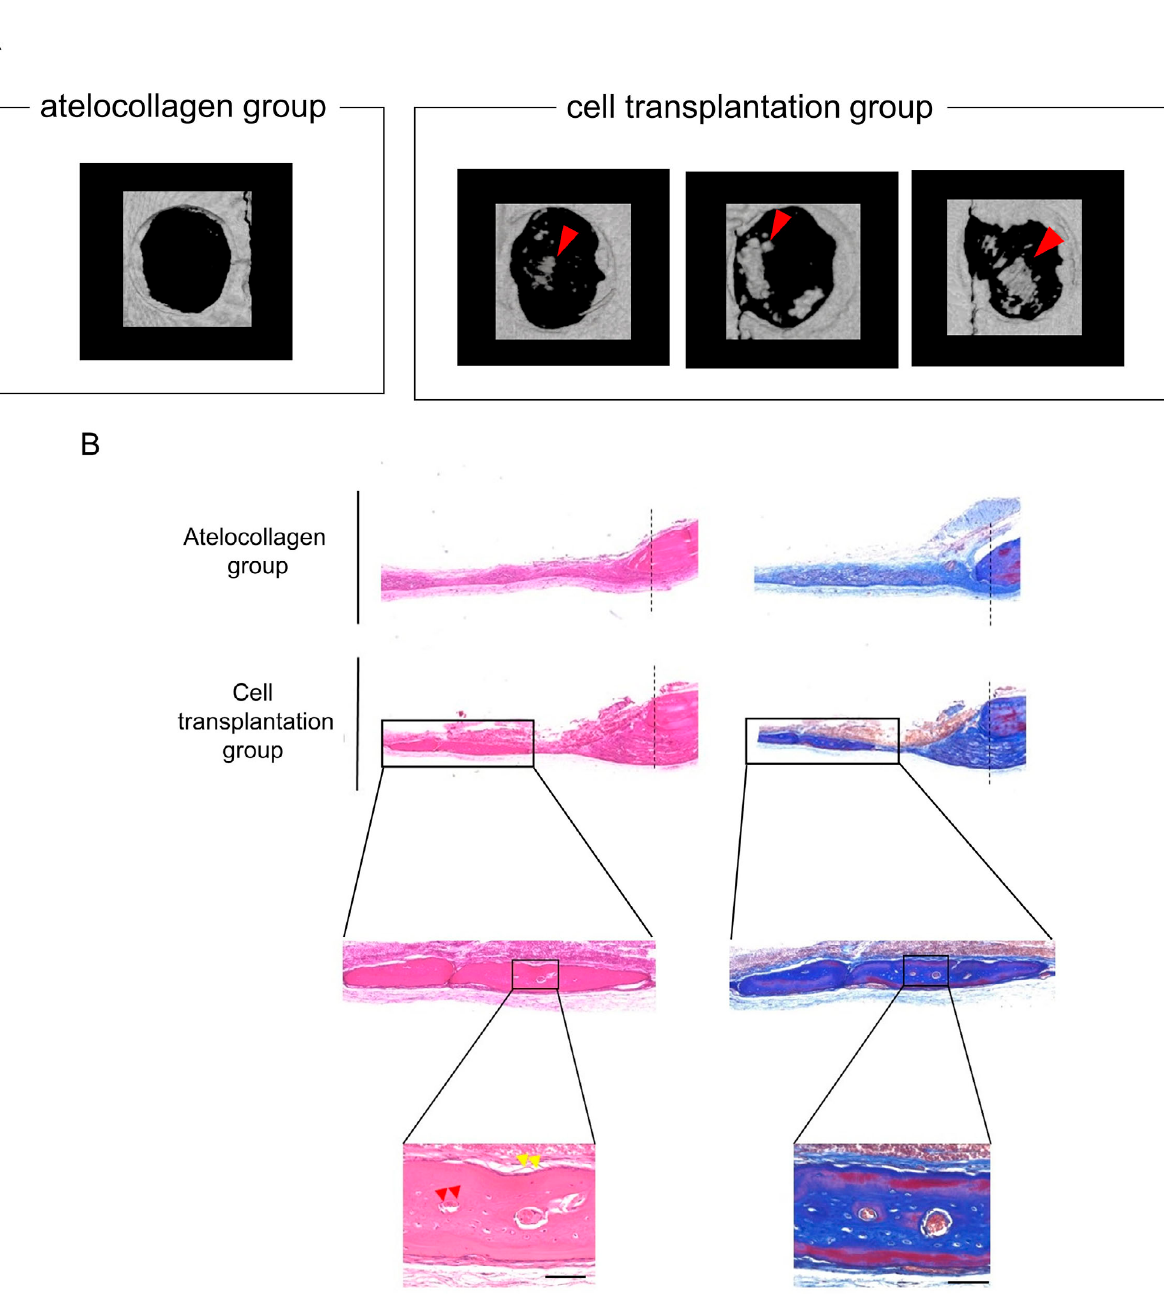
Figure 6 - Transplantation of induced osteoblasts and new bone